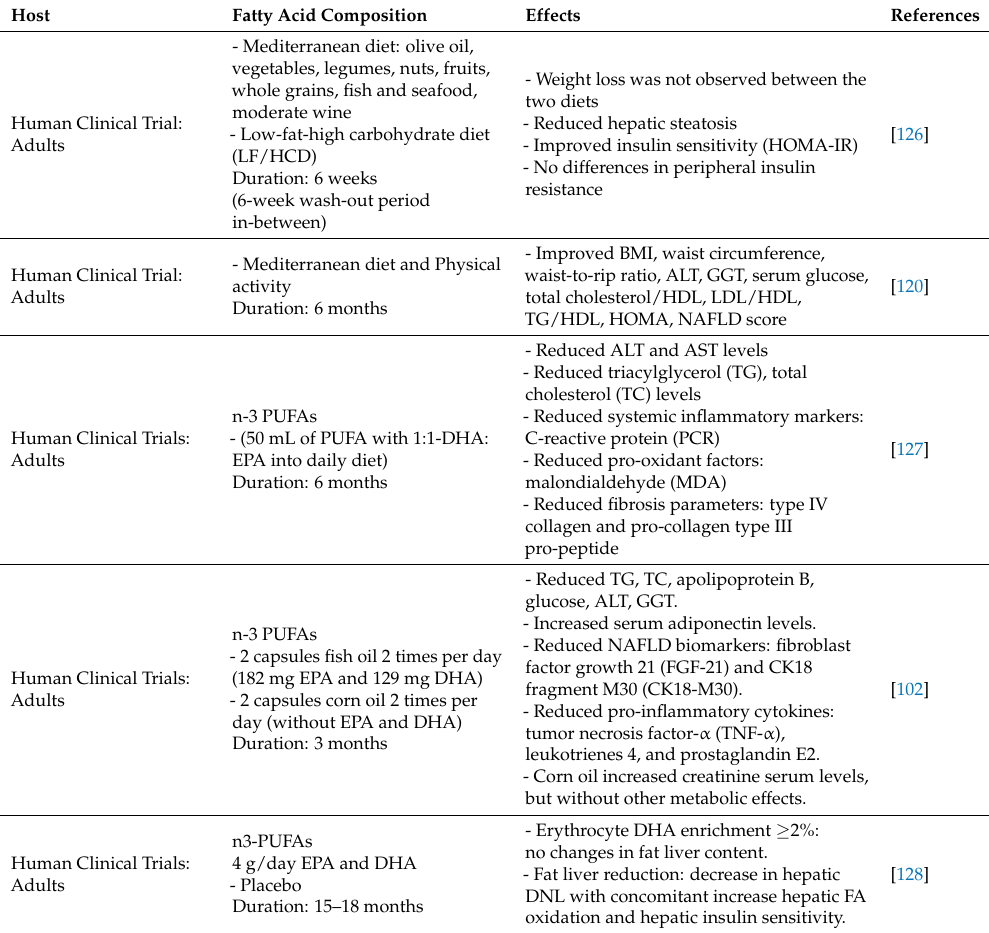
Table 7. The effects of dietary fatty acids in humans with non-alcoholic fatty liver disease